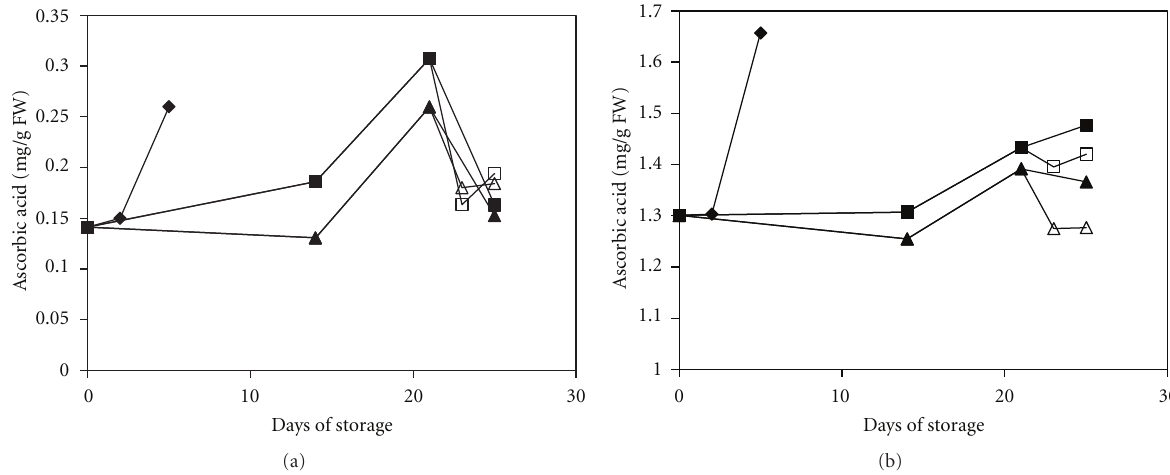
Figure 2: Changes in the ascorbic acid content of mature green peppers (a) and fully ripe/red peppers (b) for the UCRT ( (cid:2) ), MAP ( (cid:3) ), and MAP+1-MCP ( (cid:4) ) treatments during storage at 10 ◦ C; MAP ( (cid:5) ) and MAP+1-MCP ( (cid:6) ) values for the fruits transferred to room temperature at day 21. The values are the means of six replicate samples, and their S.E.s are shown.